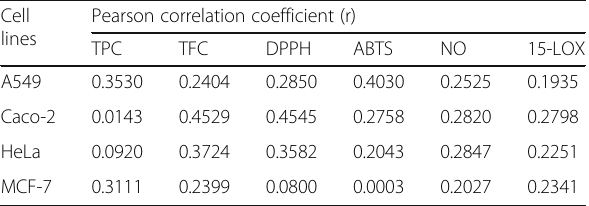
Table 4 Correlation between phytochemical content, antioxidant, anti-inflammatory and antiproliferative activity of active